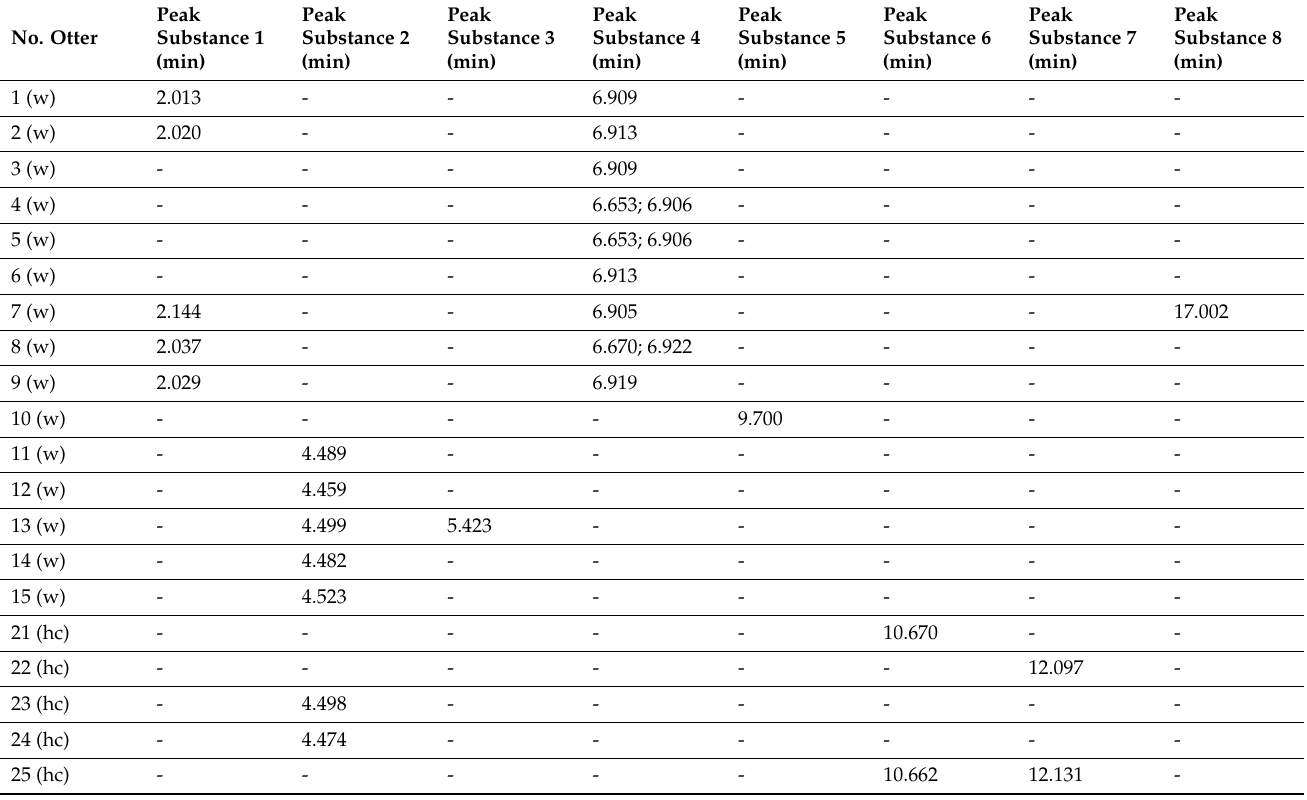
Table 2. Substances in the HPLC in 15 wild otters (w) and 5 otters under human care (hc). Absence of any substance is indicated